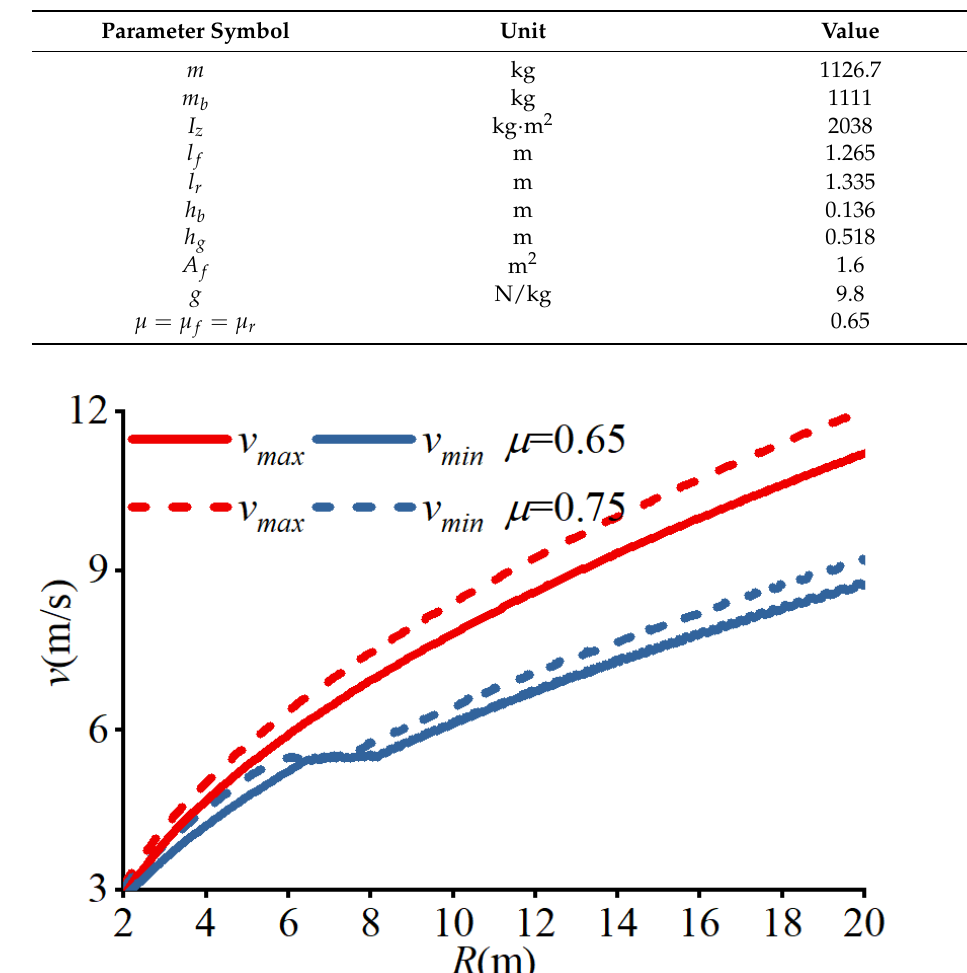
Figure 5. The velocity limitations in steady-state drifting motions in different road conditions. The vehicle can drift at greater velocities with better road conditions. Table 1. The main parameters of the vehicle in simulations.